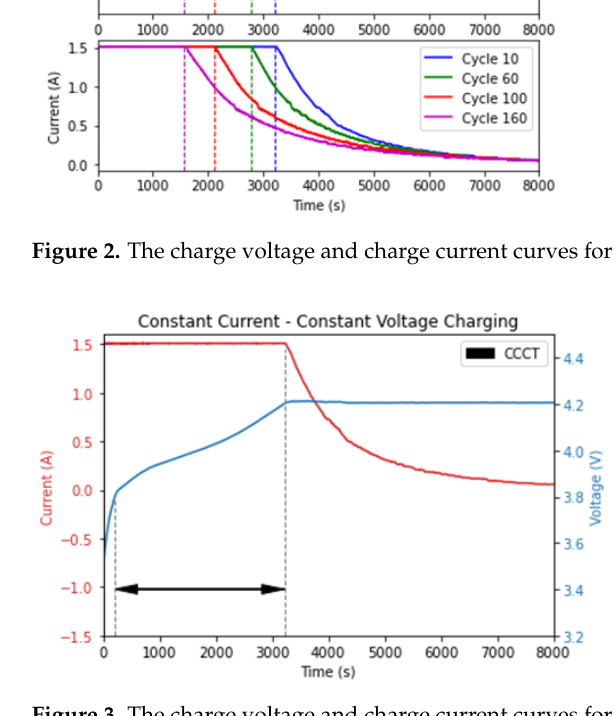
Figure 4. The constant current charge time for all cycles for the four batteries. 3.3. Correlation Analysis The correlation analysis between CCCT and capacity can be used to show the degree to which the two variables are related. The correlation coefficient indicates the strength of the correlation in a value range between 0 and 1. A value of 1 indicates a strong correlation and a value of 0 indicates a low correlation. Table 1 shows correlation coefficients close to 1 for both the Spearman and the Pear- son analyses for all batteries. This proves that there is a significant linear correlation be- tween CCCT and capacity. Accordingly, the indirect HI is able to represent the battery performance degradation instead of the capacity. Table 1. The Spearman and Pearson correlation analysis. Correlation be- tween CCCT and Capacity